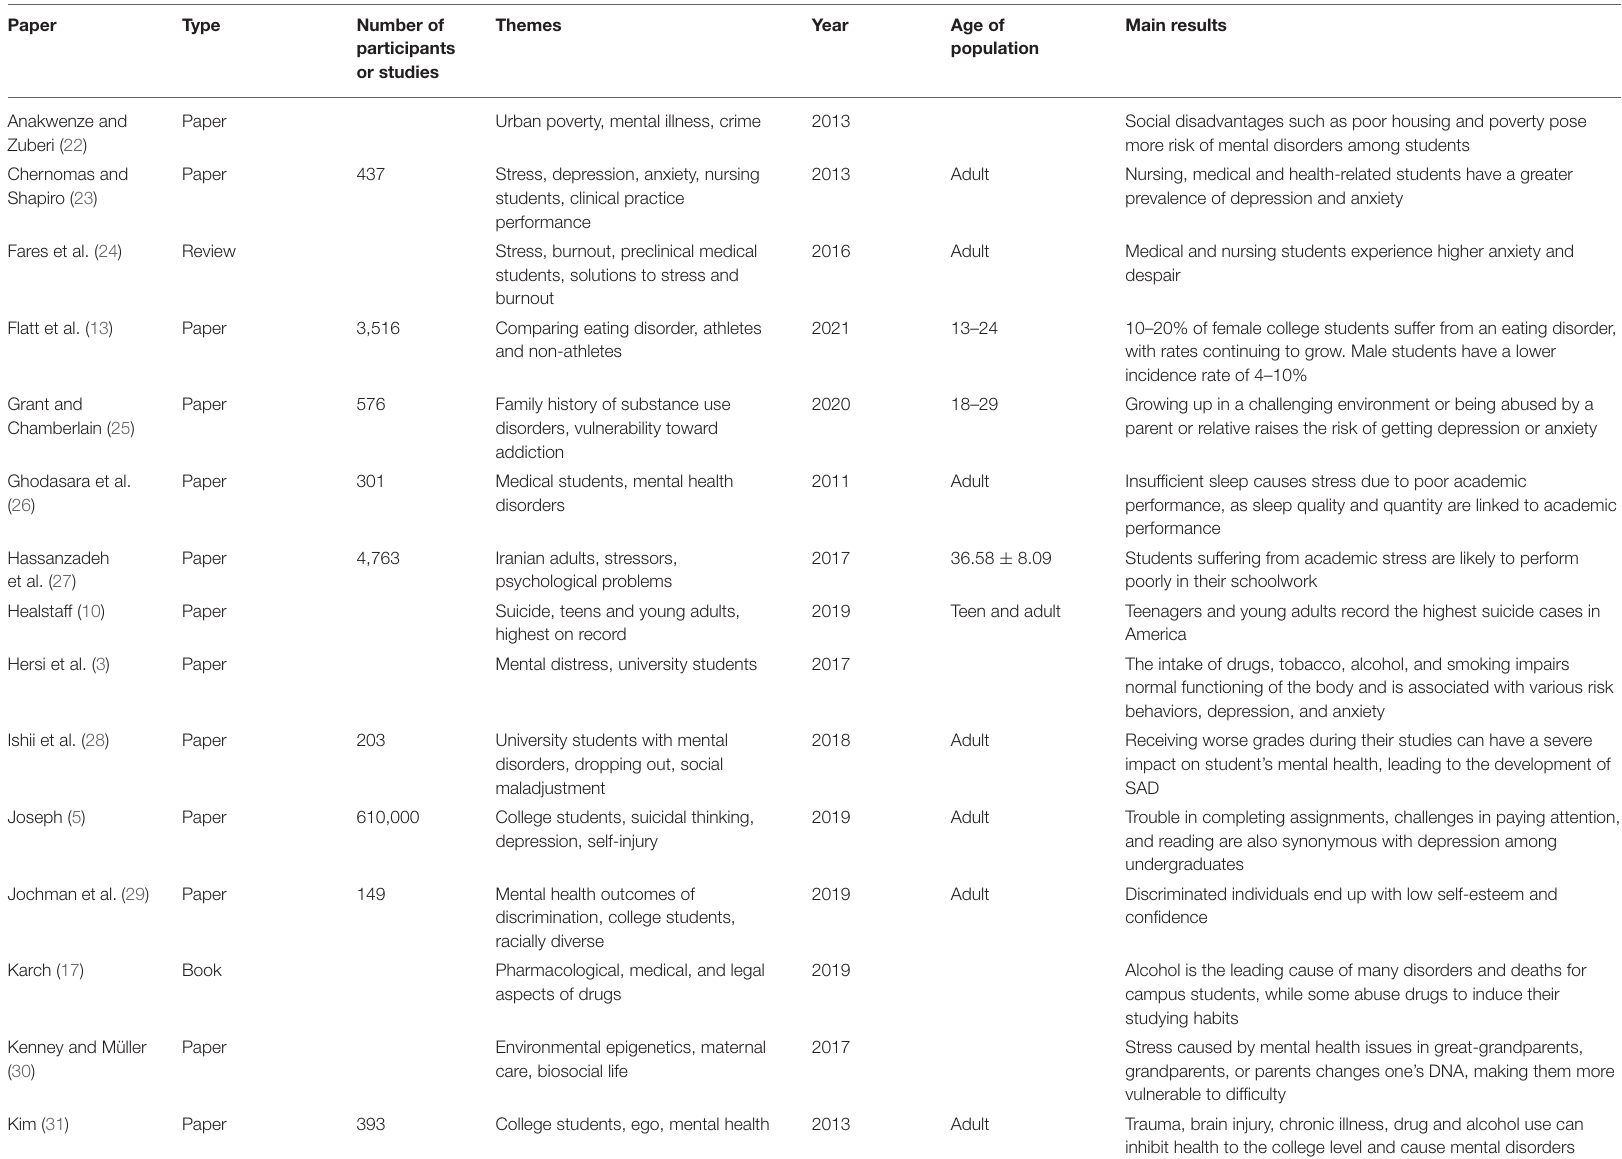
TABLE 1 | Summary of the